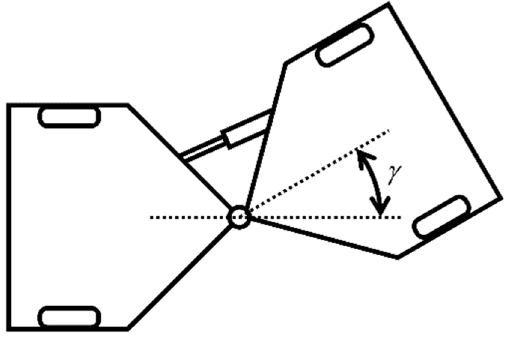
Figure 1. Structure of the articulated vehicle.